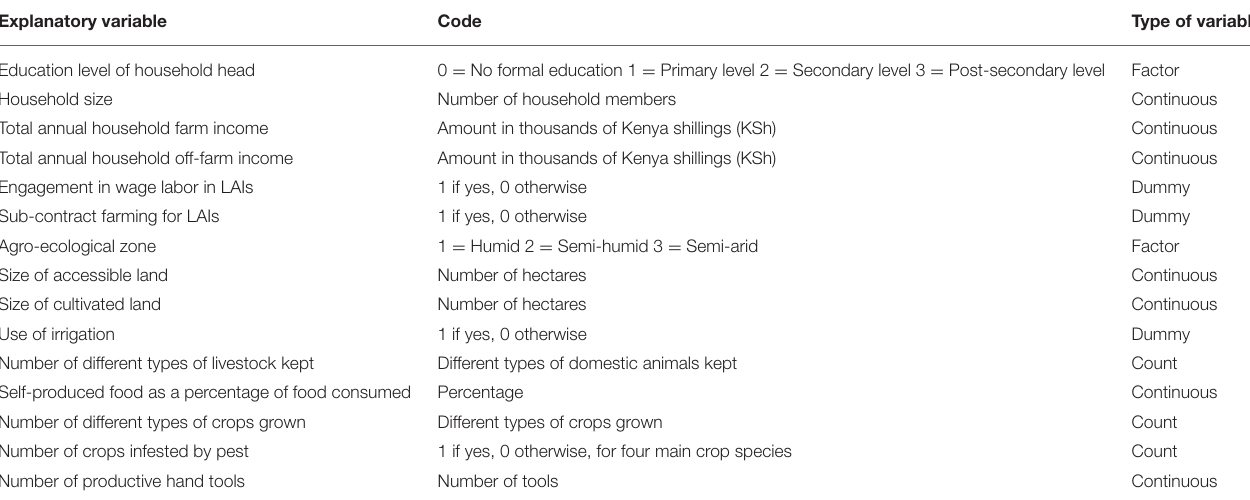
TABLE 2 | Summary of the exploratory variables used in the multiple regression model.